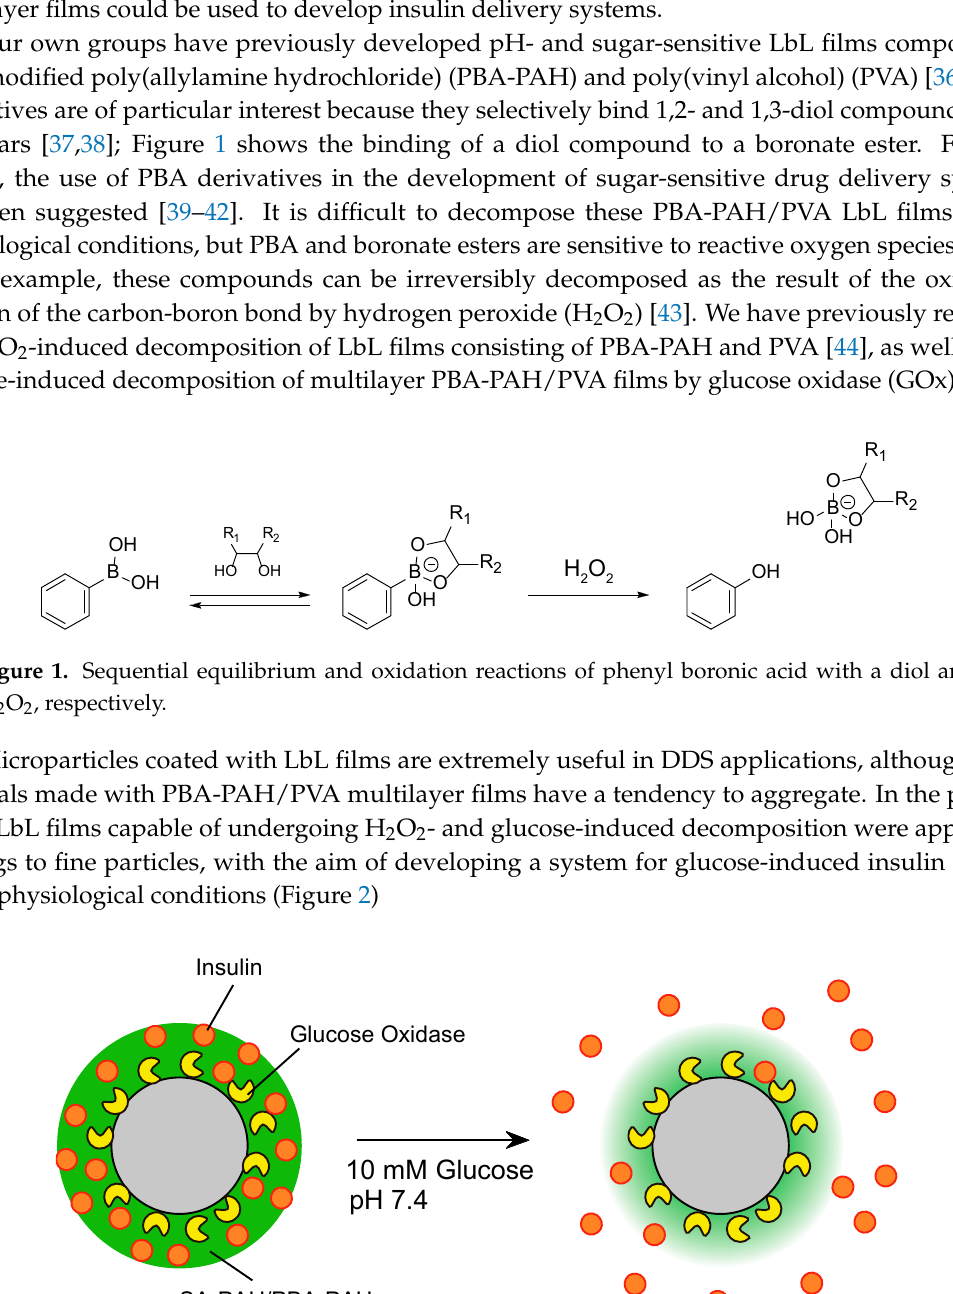
Figure 2. A schematic illustration of the functioning of a glucose-induced insulin release microparticle.